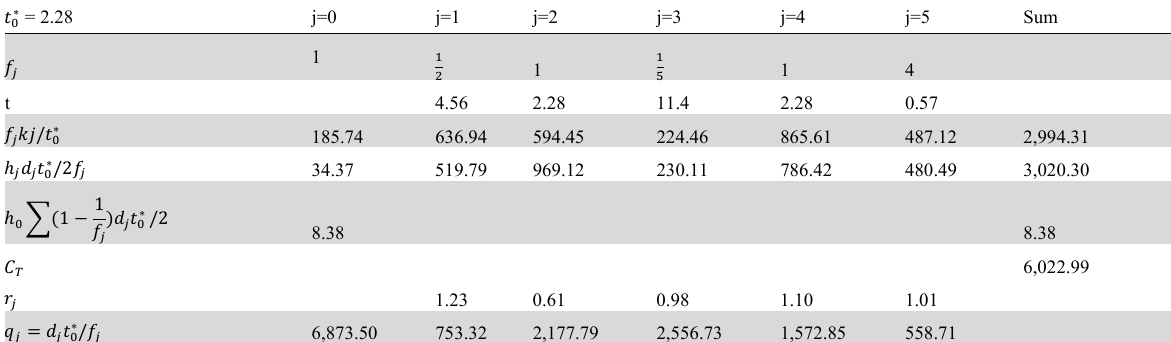
Results of the Abdul-Jalbar heuristic for a 5-retailer scenario